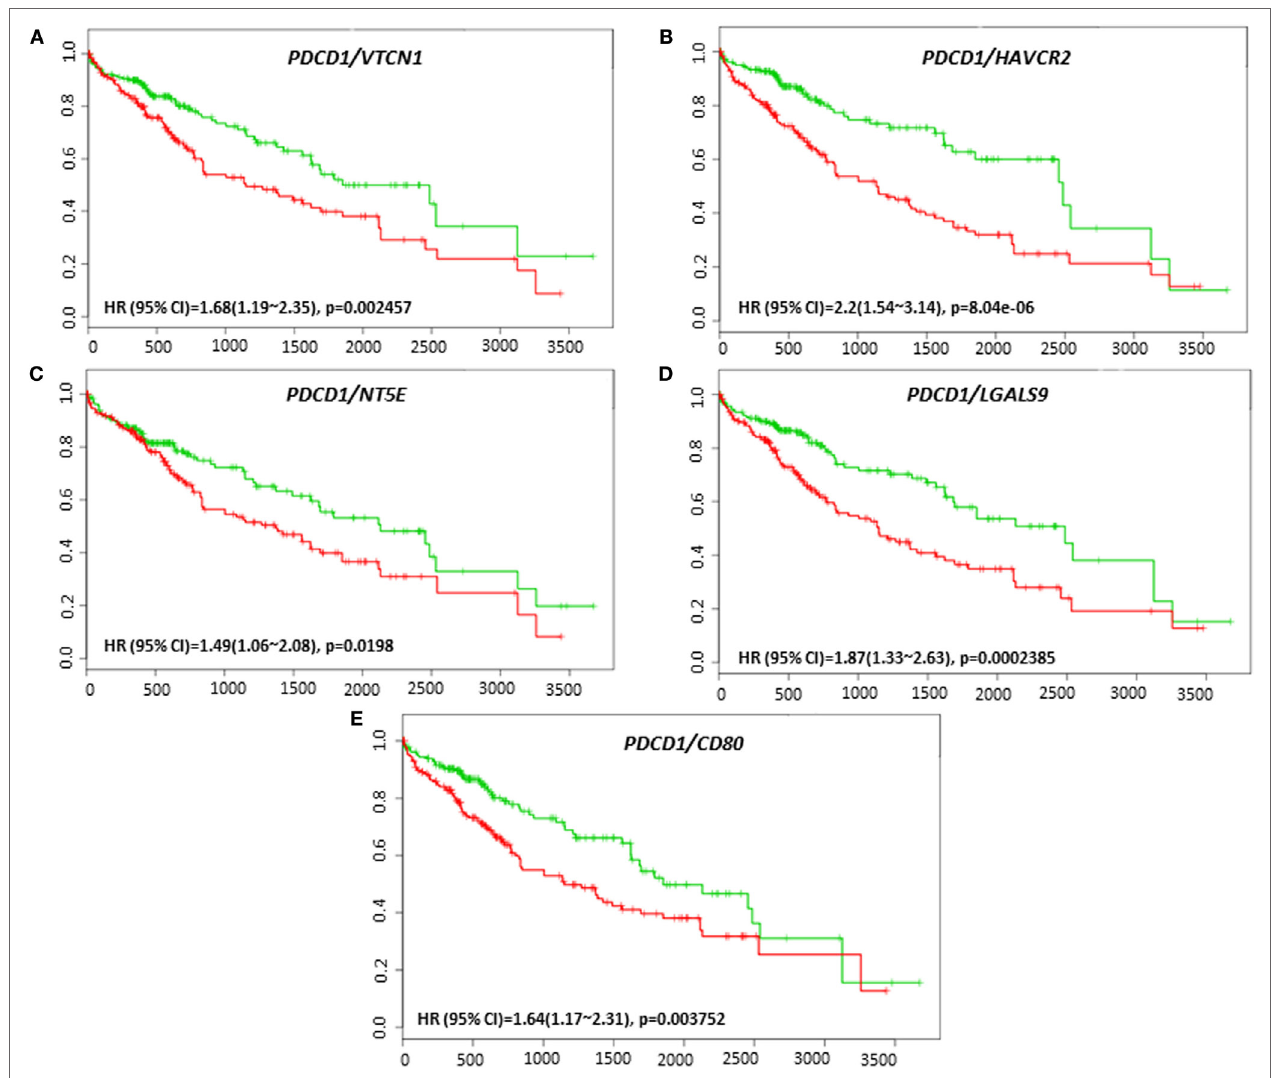
FigUre 7 | Relationship of immune modulators in combination with PDCD1 and survival in HCC patients. Kaplan–Meier survival curves generated using the SurvExpress for the analysis of survival and gene expression of (a) PDCD1/VTCN1 , (B) PDCD1/HAVCR2 , (c) PDCD1/NT5E , (D) PDCD1/LGALS9 , and (e) PDCD1/ CD80 in HCC patient samples. Green curve represents low-risk group, while red curve represents high-risk group. The study time (months) is presented on the x -axis. The insert shows the hazard ratio, confidence interval, and Log-Rank Equal Curves p value. Markers ( + ) represent censoring